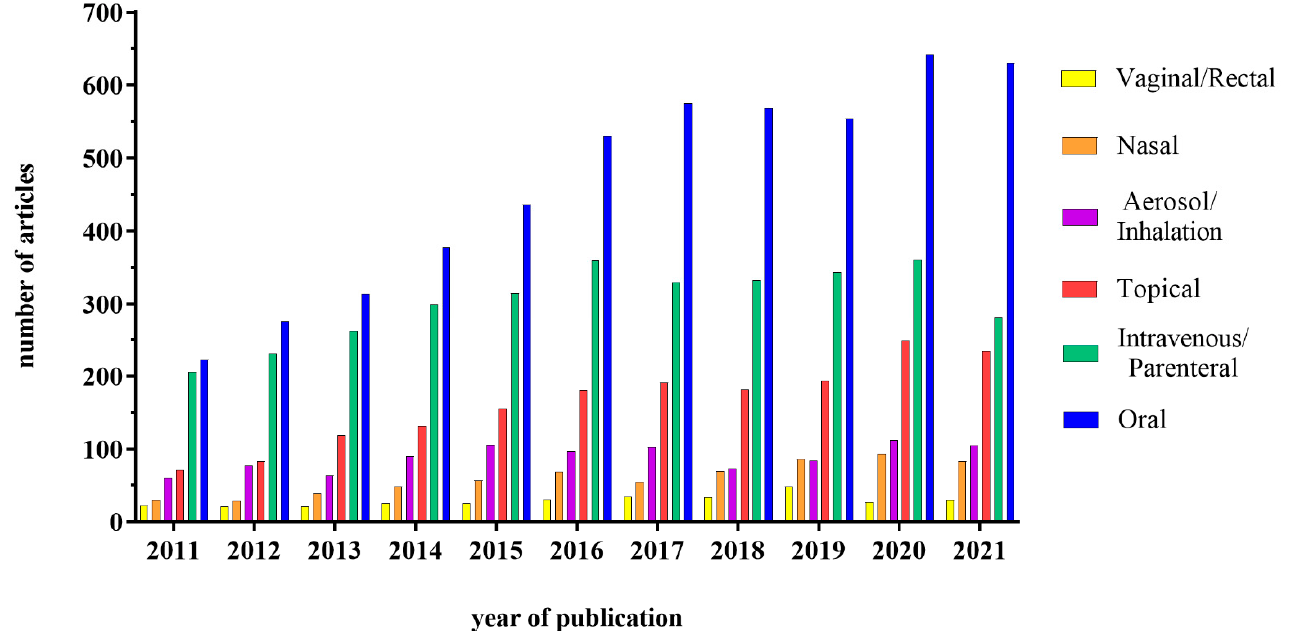
Figure 1. Graphical representation of the number of articles published on the therapeutic use of NPs subdivided according to the administration route. Database used: PubMed; Keywords used in advanced search: “Nanoparticles + “oral”; “intravenous OR parenteral”; “topical”; “vaginal OR rectal”; “aerosol OR inhalation”; “nasal” + drug delivery.